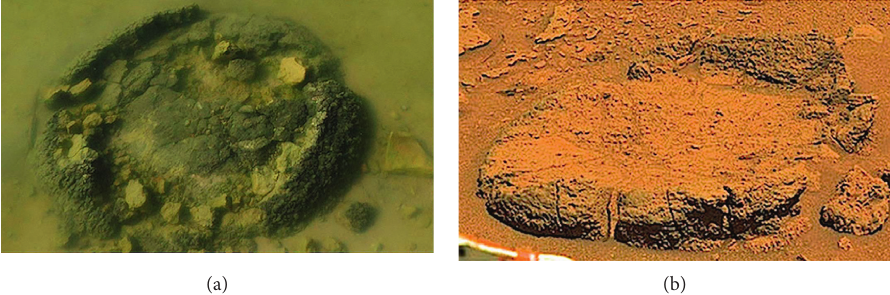
Figure 1: (a) Lake Thetis under water stromatolite (permission to reproduce photo granted by Lyn Lindfield and The- TravellingLindfields.com). (b) Sol 529: Martian specimen with evidence of concentric lamination and fossilized fenestrae (reproduced with permission from